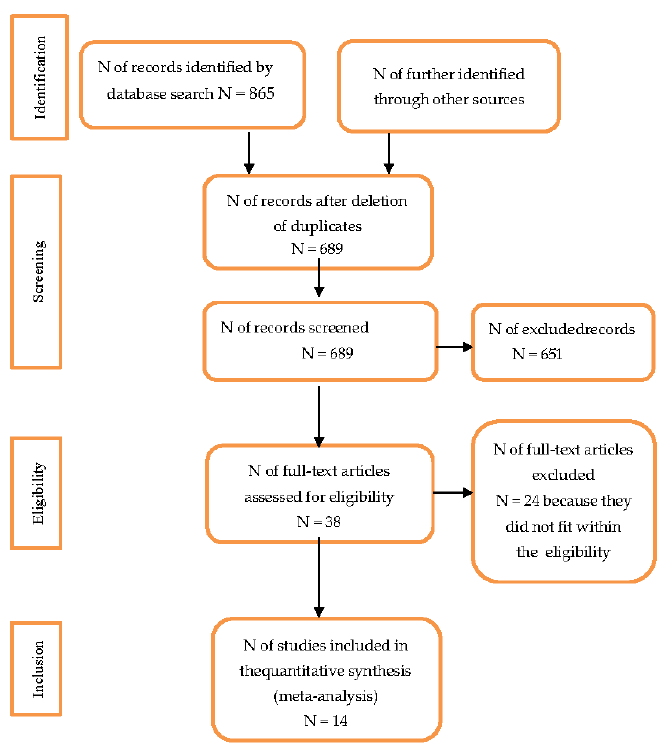
Figure 1. PRISMA 2020 flow diagram.